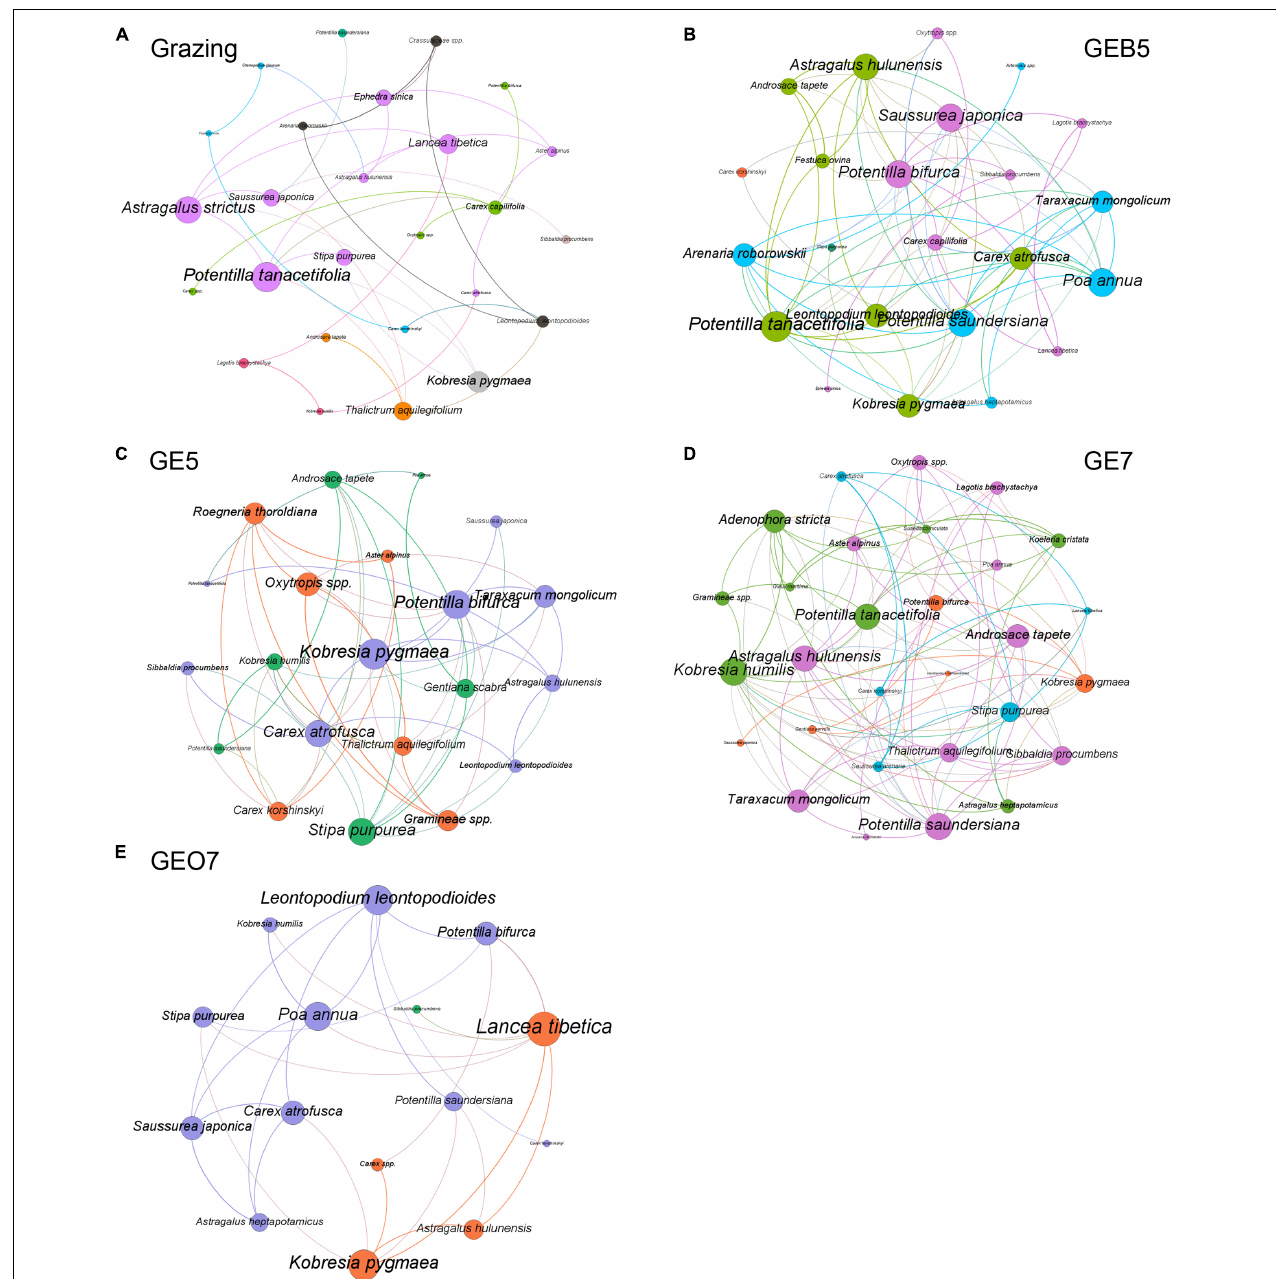
FIGURE 4 | The plant community networks under Grazing (A) , grazing exclusion below 5 years (GEB5, B ), grazing exclusion with 5 years (GE5, C ), grazing exclusion with 7 years (GE7, D ), and grazing exclusion over 7 years (GEO7, E ) in the central QTP. The network was constructed using high-frequency species (frequency over 5%). Plant species is the node, and the link between significant-correlated species is the edge in a network. Plant species were separated and colored according to modules, and the size of dots was determined by the hub index of species in each